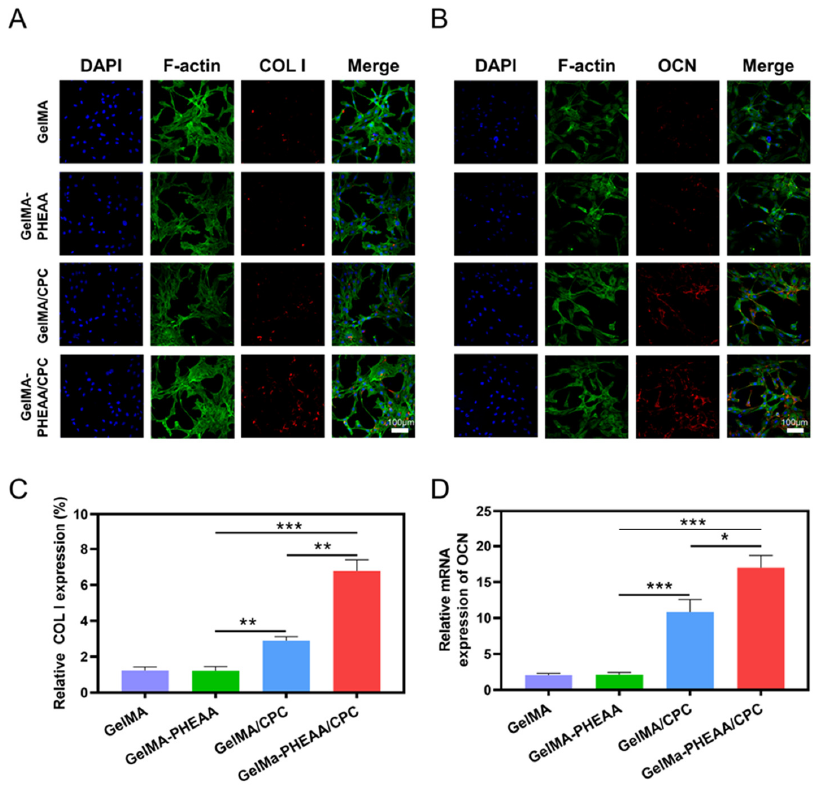
Figure 6. Immunofluorescence expressions stained by DAPI, F-actin, COL I ( A ), OCN ( B ), and their Merged images of GelMA, GelMA-PHEAA, GelMA/CPC, and GelMA-PHEAA/CPC on Days 21. Statistics of relative expression of COL I ( C ) and OCN ( D ) for GelMA, GelMA-PHEAA, GelMA/CPC, and GelMA-PHEAA/CPC in Days 21. The data was presented as the mean ± SD (n = 3), * p < 0.05, ** p < 0.01, *** p < 0.001.